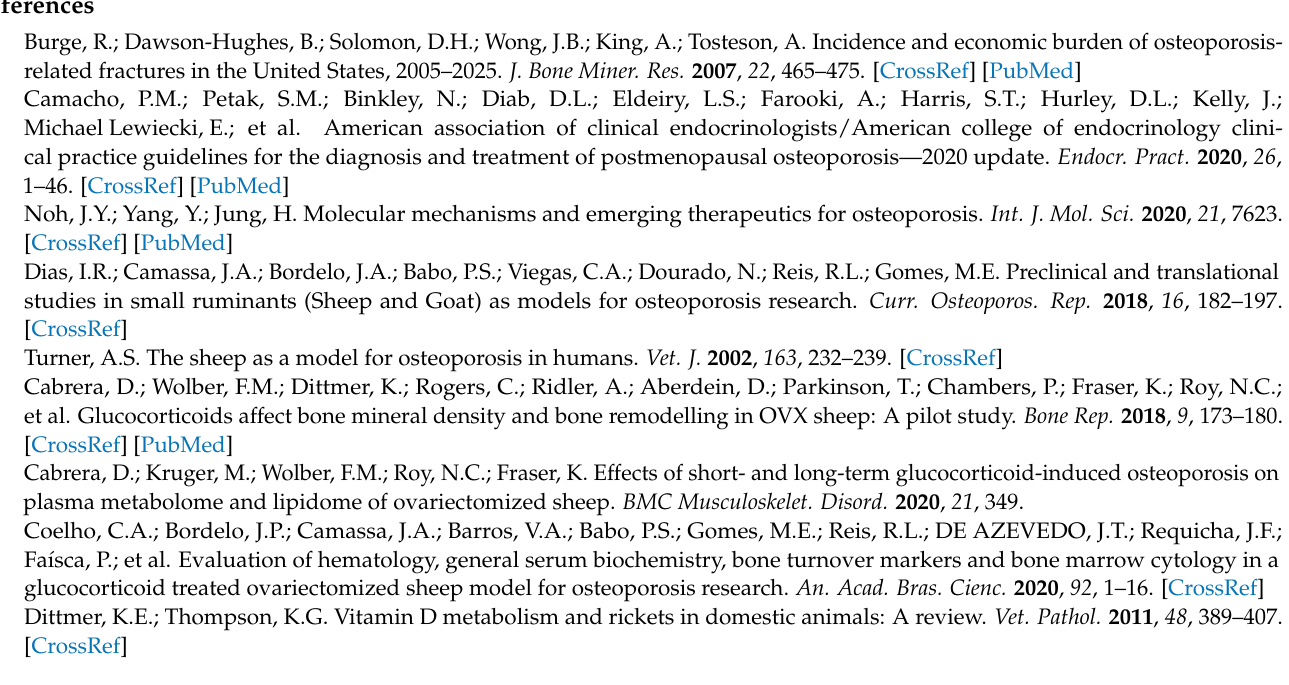
Figure S3. Principle component analysis of overall phosphatonin and vitamin D-related genes in ewes based on serum 25-hydroxyvitamin D concentrations. Table S1: Ovine phosphatonin and vitamin D-related kidney genes—transient receptor potential cation channel subfamily V member 5 ( TRPV5 ), transient receptor potential cation channel subfamily V member 6 ( TRPV6 ), Calbindin D9k ( calD9k ), Calbindin D28k ( calD28k ), plasma membrane calcium ATPase ( PMCA ), sodium calcium exchanger 1 ( NCX1 ), cytochrome P450 family 27 subfamily B polypeptide 1 ( CYP27B1 ), cytochrome P450 family 24 subfamily A polypeptide 1 ( CYP24A1 ), vitamin D receptor ( VDR ), fibroblast growth factor receptor 1 IIIc ( FGFR1IIIc ), α -klotho ( klotho ), sodium-phosphate co-transporter 1 ( NPT1 ), NPT2a , NPT2c , parathyroid hormone 1 receptor ( PTH1R ), succinate dehydrogenase complex ( SDH ) and phosphoglycerate kinase 1 ( PGK1